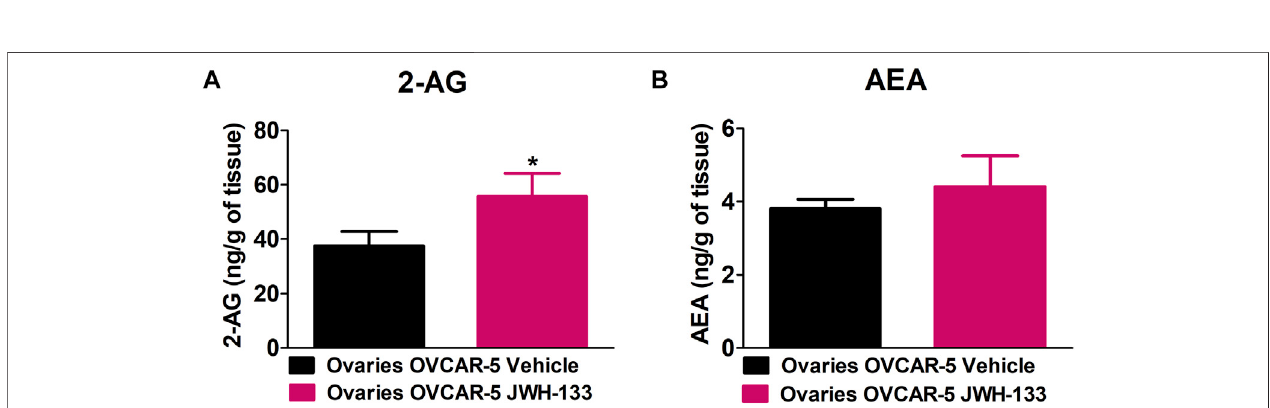
FIGURE3| Nochangeinthelevelsof2-arachidonoylglycerol(2-AG)andanandamide(AEA)levelsintheovariesofcontrol(noOVCAR-5tumor)relativetoOVCAR- 5 ectopic xenograft tumor in immunocompromised SCID-SHO female mice. No changes in AEA (A) and 2-AG (B) levels were observed in the ovaries of control (no OVCAR-5 ectopic tumor) in comparison to OVCAR-5 ectopic ovarian tumor in immunocompromised SCID-SHO female mice. Data are expressed as mean ± S.E.M. (ovaries in control (no OVCAR-5 tumor) SCID-SHO female mice, n = 5 – 7 SCID-SHO females; ovaries in OVCAR-5 tumor SCID-SHO female mice, n = 5 – 7 SCID- SHO